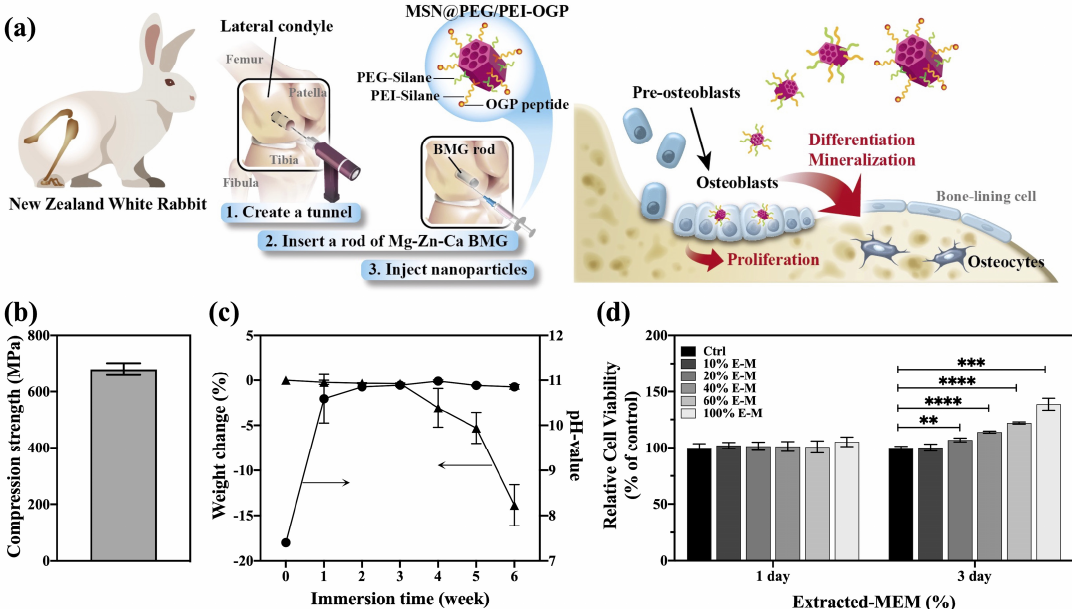
Figure 1. ( a ) Schematic illustration of Mg − Zn − Ca bulk metallic glass combined with mesoporous silica nanoparticle@PEG/PEI-osteogenic growth peptide for promoting bone regeneration in the tun- nel. ( b ) Compressive strength measurement of Mg 66 Zn 29 Ca 5 BMG. ( c ) Time − dependent degradation behavior of Mg 66 Zn 29 Ca 5 BMG immersed in Hank’s solution. ( d ) Cell viability of MC3T3 − E1 treated with different concentrations of extracted − α MEM. ( n = 3 per group; data are the mean ± standard deviation, ** p < 0.01, *** p < 0.001, **** p < 0.0001). The circle represents the pH-value (right y-axis), and the triangle refers to the weight change (left y-axis) determined at each corresponding immersion time